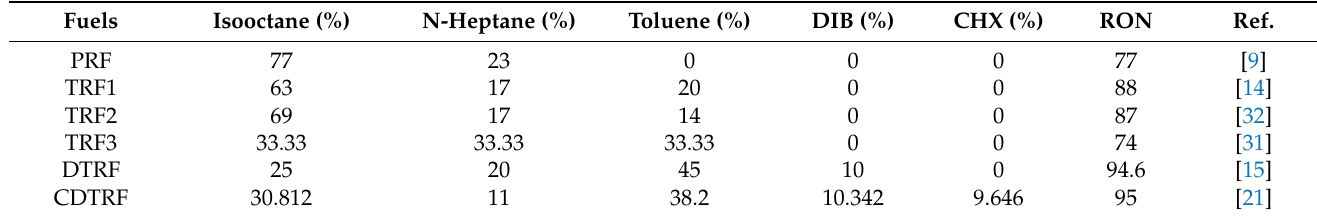
Table 3. Composition of different gasoline-surrogate fuels (by volume fraction).